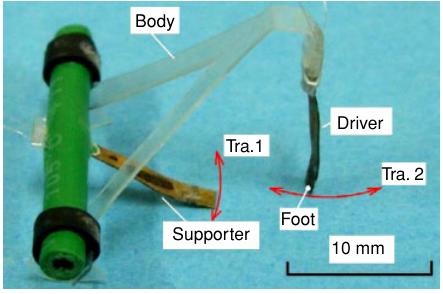
Figure 4 The structure of the biomimetic